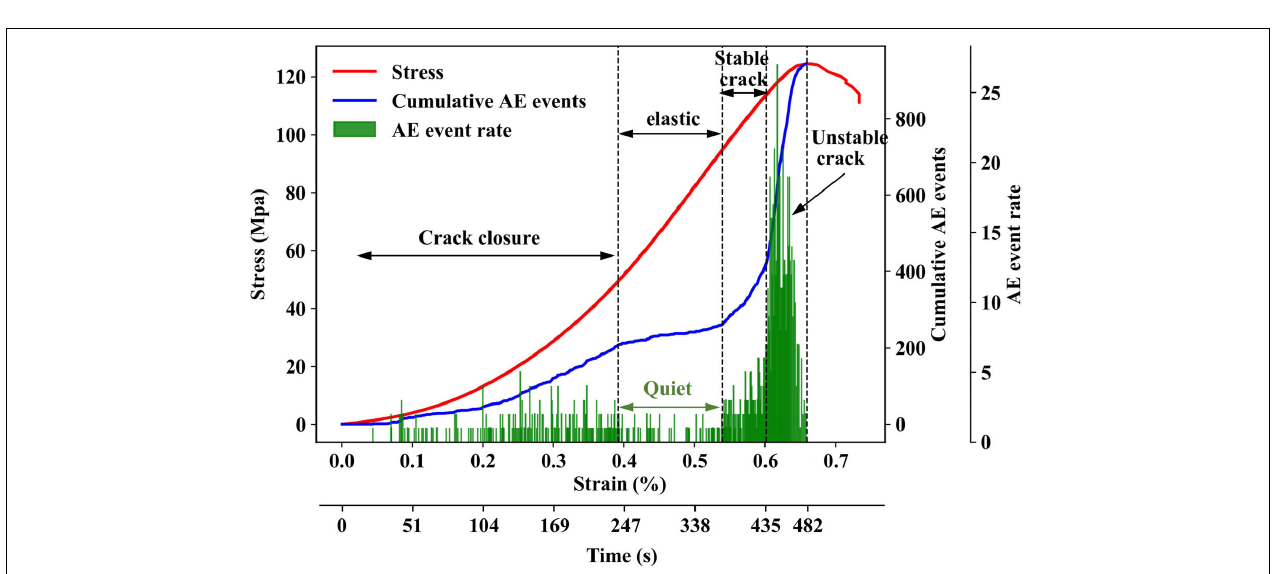
FIGURE 7 | Damage evolution of granite on time and strain scales under uniaxial compression in dry state. Divides the different stages of the uniaxial compression process according to the AE characteristics and stress-strain.